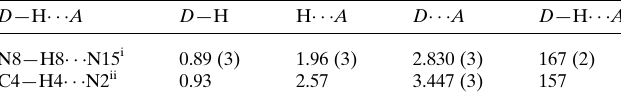
Table 1 Hydrogen-bond geometry (A˚ , (cid:2) ).